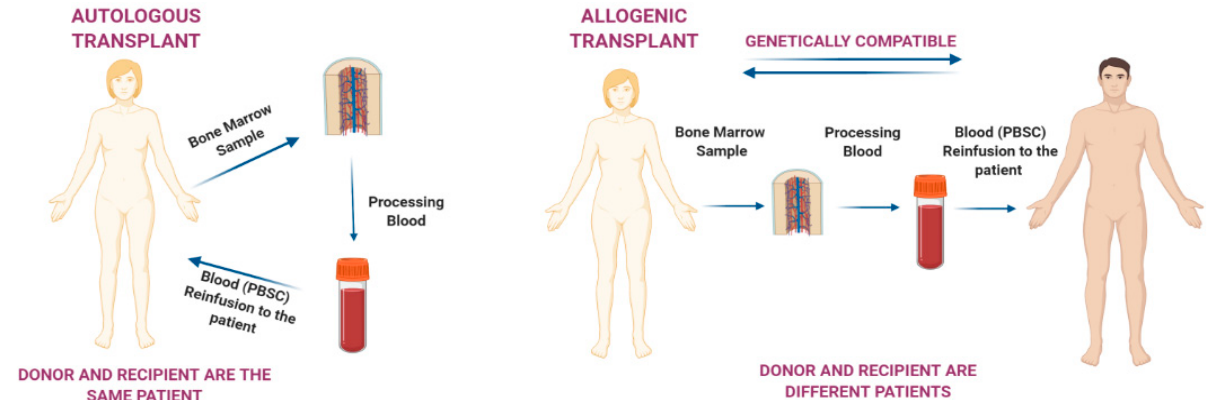
Figure 1. Difference between autologous and allogenic transplants.